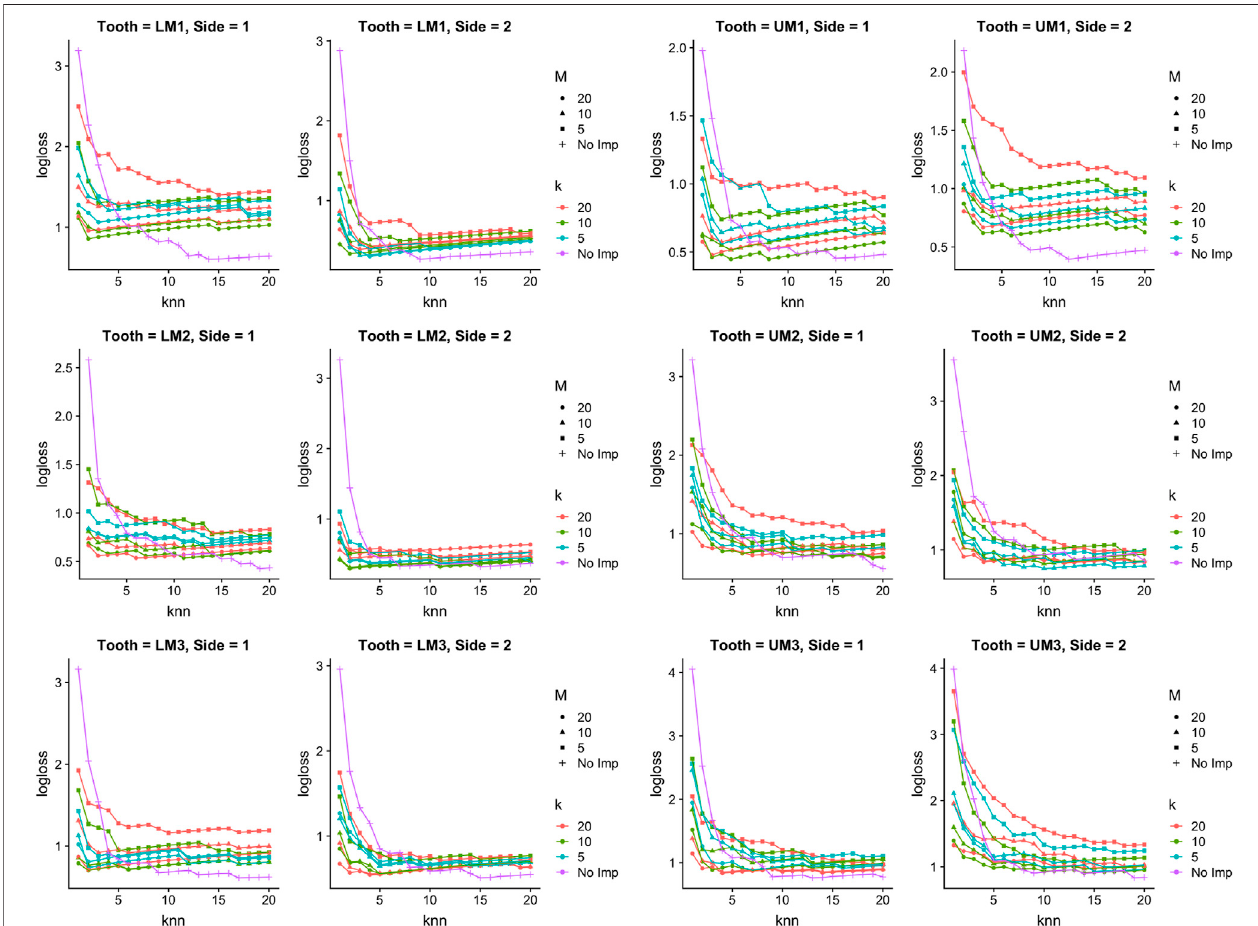
FIGURE 5 | Tribe classi fi cation in simulated setting . Log-loss for the knn-imp classi fi er as a function of number k n neighbors for different values of donor set size K and number of imputations M ; purple “ No-imp ” curve represents the same for the knn classi fi er.